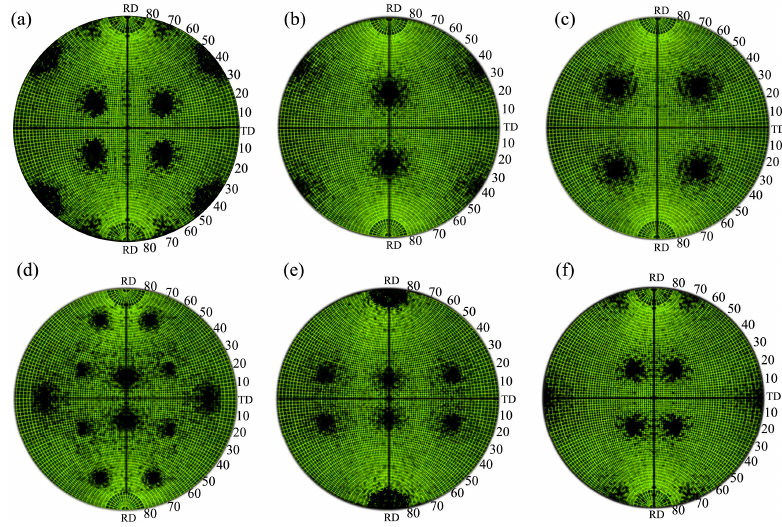
Figure 11. {111} pole figures of various standard textures: ( a ) P-texture, ( b ) Goss-texture, ( c ) Cube-texture, ( d ) R-texture, ( e ) Copper-texture and ( f ) Brass-texture.